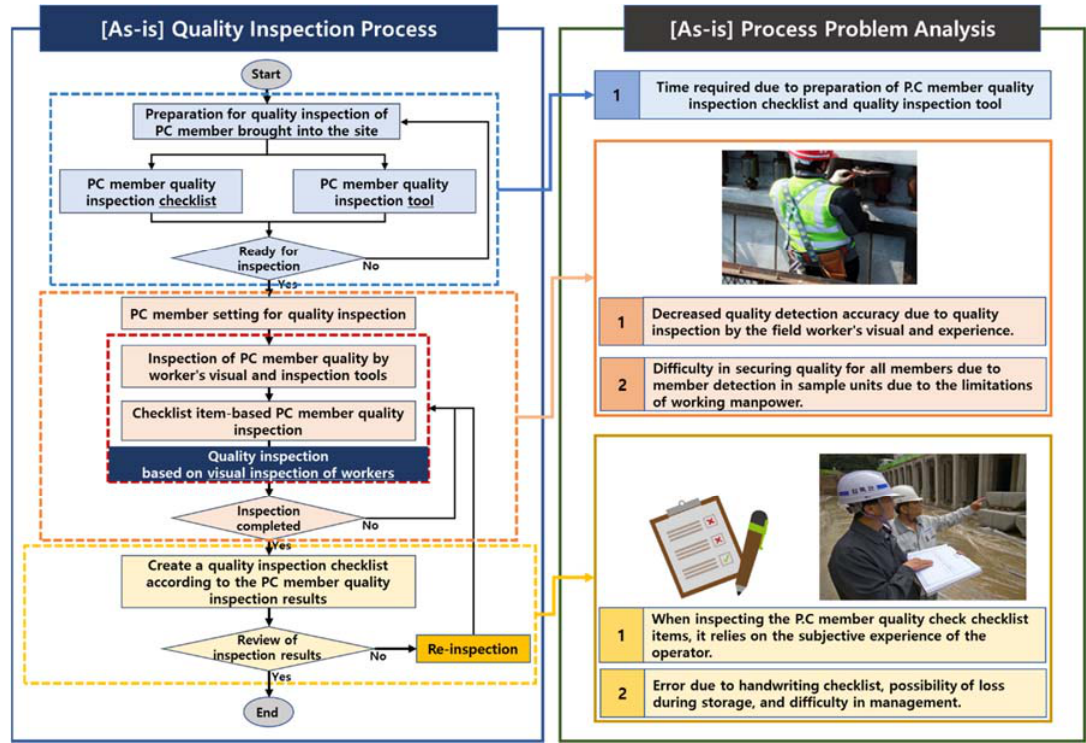
Figure 3. As ‐ is on ‐ site quality inspection process and related problems.